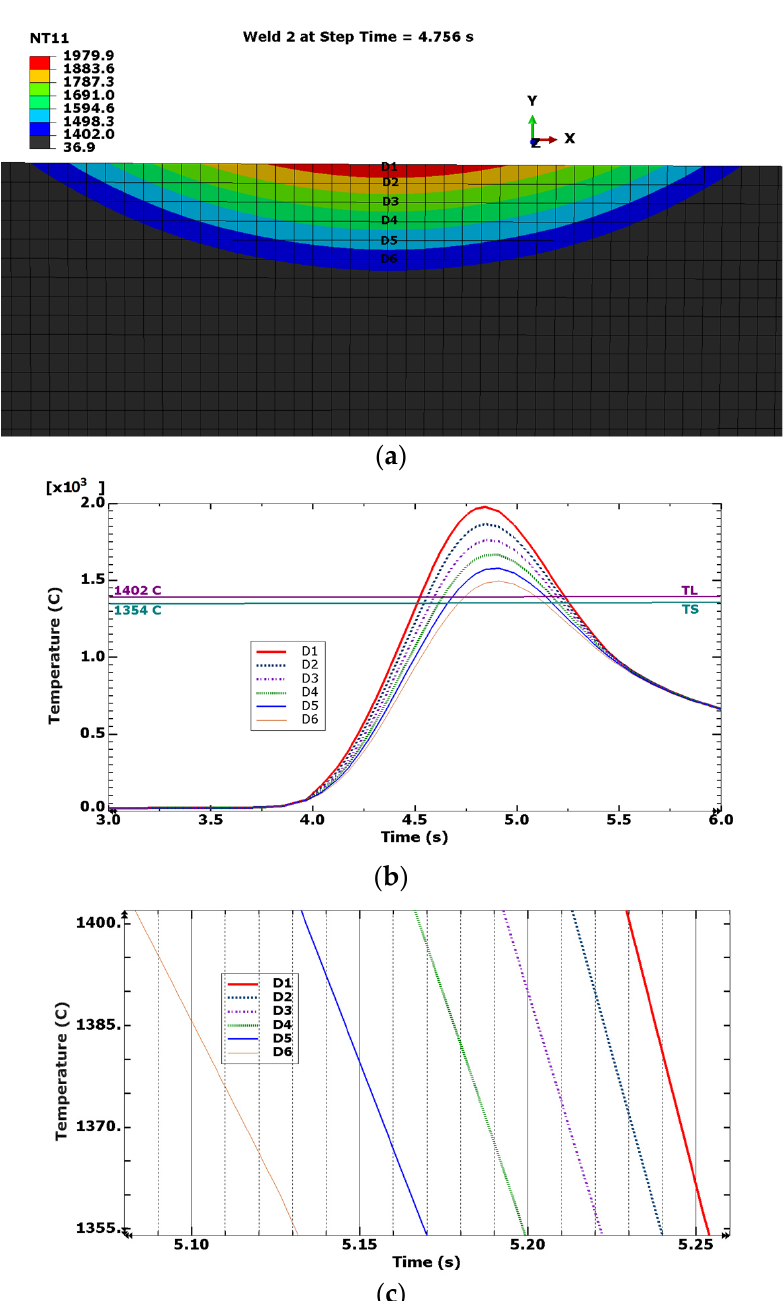
Figure 7. ( a ) Cross-section of the meso weld pool showing six locations (D1–D6) in Path 3; ( b ) thermal cycles (and the liquidus T L and solidus T S temperatures) at the documented locations; and ( c ) cooling rates (through the solidification temperature range) at the selected six locations.